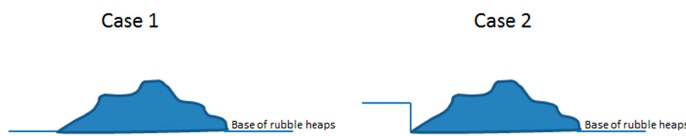
Figure A1. Example of building’s base height retrieving. The elevation is estimated from the lower (visible) point adjacent the rubble heap. For instance, in case 2 the lower elevation (right side) is selected. Method